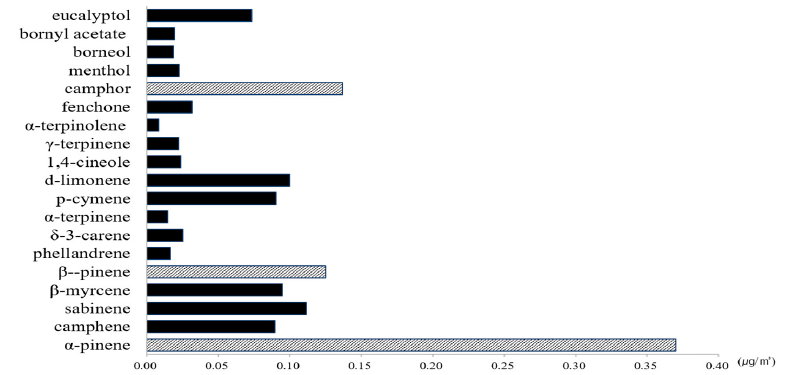
Figure 4. The characteristics of NVOCs at Betula platyphylla forest.